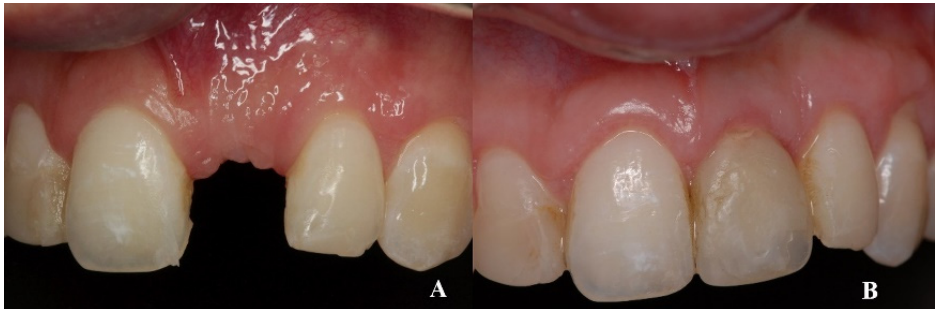
Figure 6. ( A ) Initial provisionalization (adhesive bridge). ( B ) Subsequent customized provisionalization, screwed down to create the emergence profile.